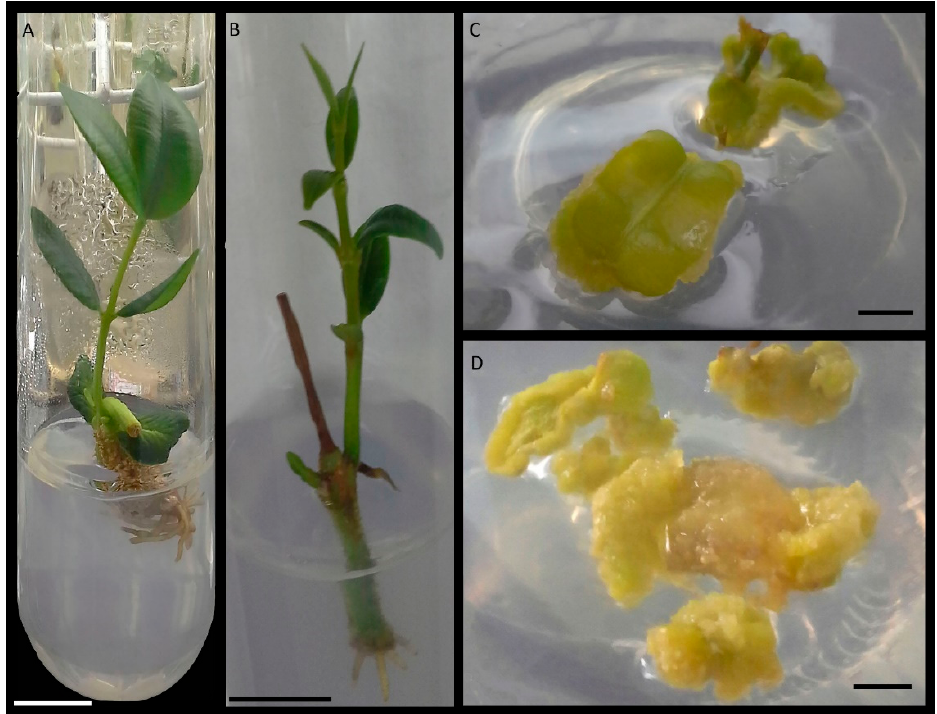
Figure 2. Representative illustration of Hancornia speciosa in vitro establishment and multiplication by nodal segments and callus induction. ( A ) In-vitro-established seedlings of H. speciosa . ( B ) Shoot formation from nodal segments. ( C ) H. speciosa starting callus formation. ( D ) H. speciosa callus after subcultures. Bar = 1 cm.